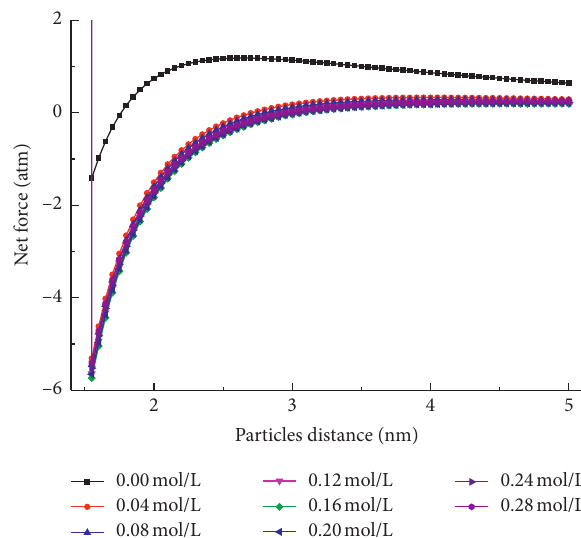
Figure 6: The relationship between net force and particle distance.